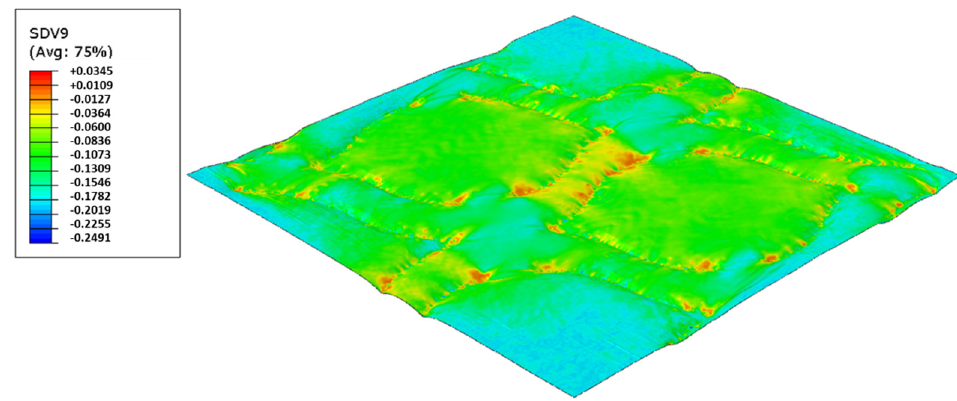
Figure 17. Deco die 75 Sh-A (CR PR), Plastic field.